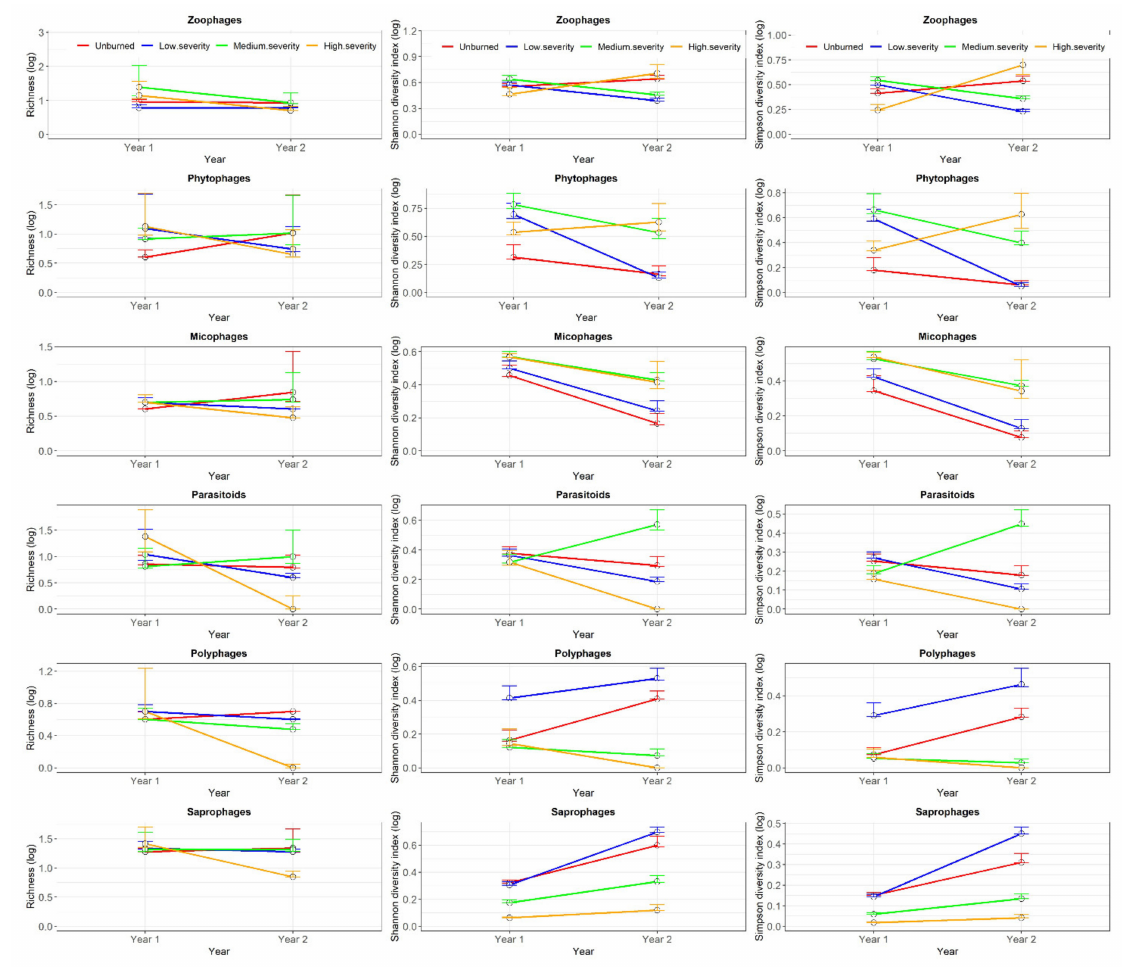
Figure 2. Diversity indices (richness, Shannon, and Simpson) of arthropods belonging to different guilds under different fire severity treatments collected during two sampling years (2017 and